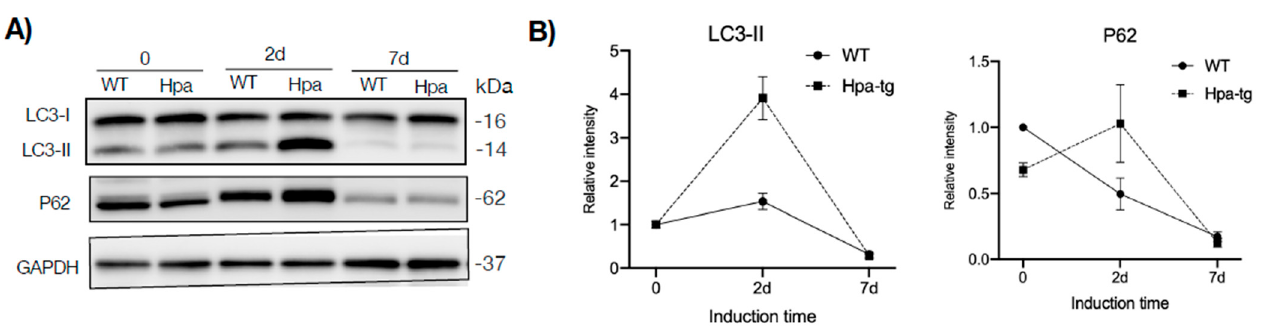
Figure 6. Autophagy. Frozen liver tissues were homogenized in RIPA buffer and total protein was quantified. ( A ) Equal amounts of tissue lysates (40 µg protein; n = 4–7 mice per group) were applied onto 8–15% SDS-PAGE and subjected to Western blotting probed with the indicated antibodies. ( B ) Band intensity was quantified by Image Lab software and the naïve WT value was set arbitrarily to a value of 1. Data are expressed as mean ± SEM of three experiments (each representing pooled liver tissue extracts derived from 4–7 mice per group).